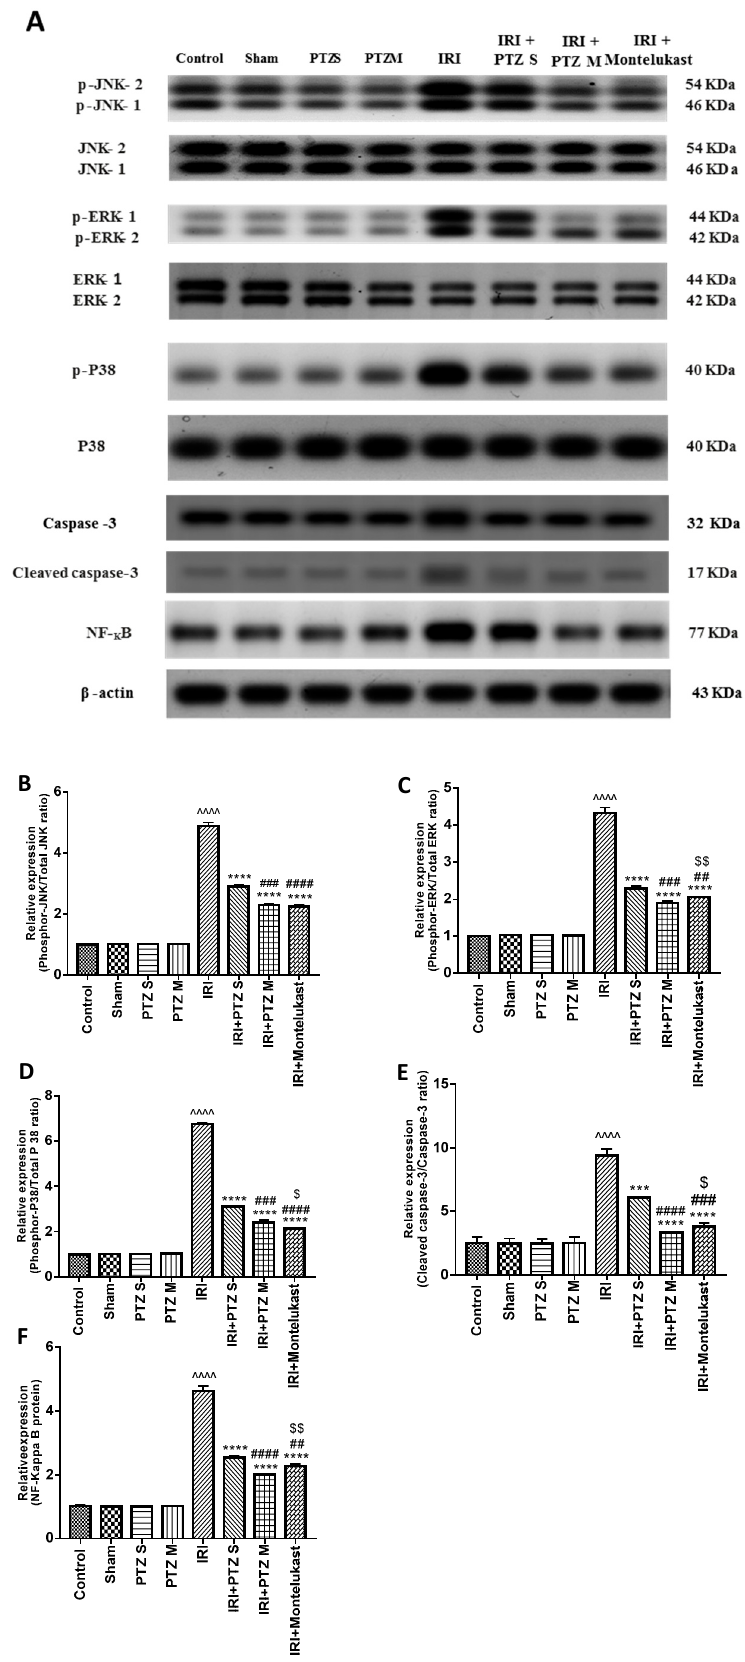
Figure 4. Effect of pantoprazole on the expression of JNK1/2, ERK1/2, p38, caspase-3, and NF- κ